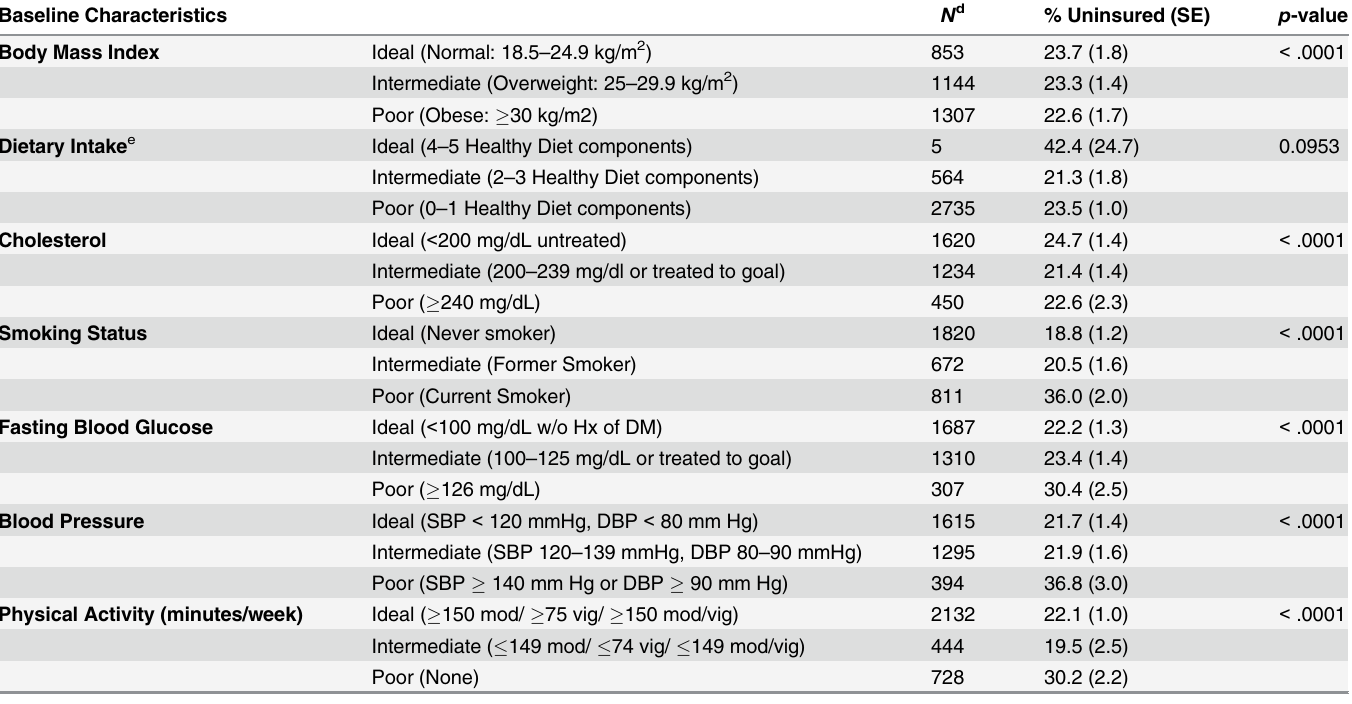
Table 2. Sample-weighted, Age-Adjusted Cardiovascular Health Factors of 2007 – 2010 NHANES Population (N = 3304) by Health Insurance Status. Baseline